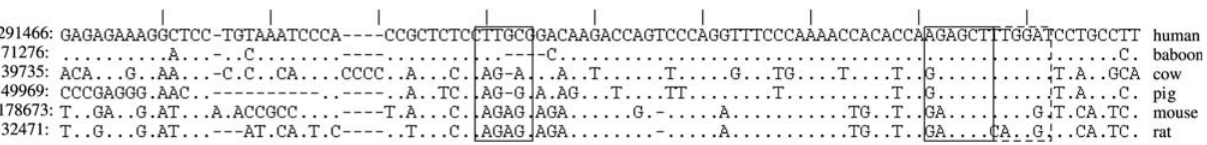
Figure 6 - A region from HoxC cluster exhibiting several blocks of good differential conservation, otherwise not obvious within the environment. Solid and dashed lines indicate different kinds of differential conservation. Dots indicate the same letter as in row 1 (human).